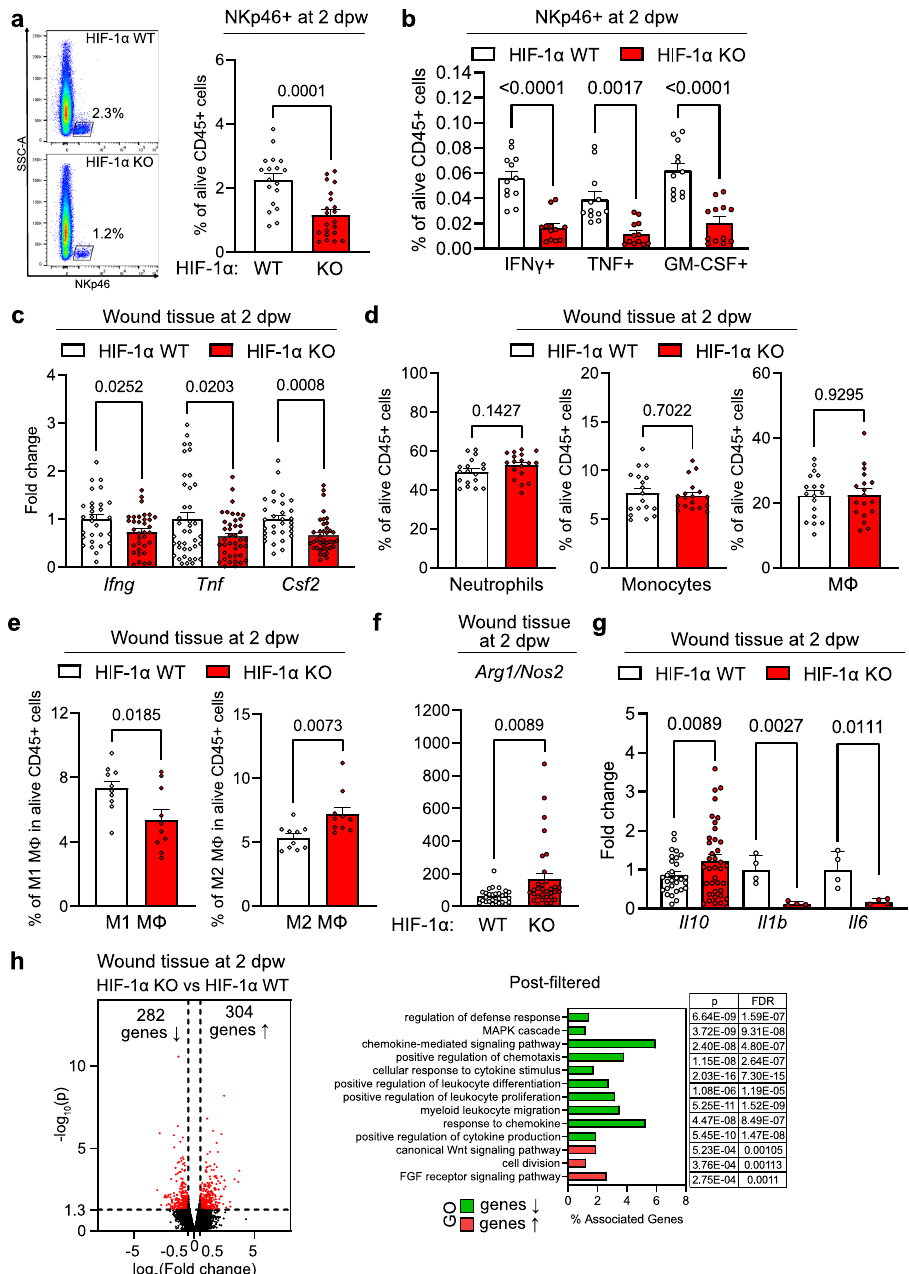
Fig. 2 HIF-1 α in NK cells controls the early cytokine response and skin regeneration. Analysis of skin wounds from WT and HIF-1 α KO animals at 2 days post wounding (dpw). a Left, FACS plots showing the percentage of NKp46 + cells within CD45 + cells. Right, quanti fi cation of NKp46 + cells, pooled data of 4 experiments, ( n = 18 mice for WT and n = 21 for HIF-1 α KO), two-tailed Student ’ s t test. b FACS analysis of IFN γ -, TNF- and GM-CSF-expressing NKp46 + NK1.1 + cells, pooled data of 3 experiments, ( n = 12 mice), two-tailed Student ’ s t test. c Gene expression of Ifng, Tnf and Csf2 , pooled data of 4 experiments, ( Ifng , n = 30 wounds for WT and n = 32 for HIF-1 α KO; Tnf n = 40 for WT and n = 40 for HIF-1 α KO; Csf2 , n = 30 for WT and n = 40 for HIF- 1 α KO), two-tailed Student ’ s t test. d FACS analysis for neutrophils (CD11b + , Ly6G + ), monocytes (CD11b + , Ly6C + ) and macrophages (CD11b + , Ly6C + , F4/80 + ), pooled data of 4 experiments, (n = 18 mice), two-tailed Student ’ s t test. e FACS analysis for M1 (CD80 + , MHCII + ) and M2 macrophages (CD206 + ), pooled data of 3 experiments, ( n = 10 mice), two-tailed Student ’ s t test. f Ratio of Arg1 and Nos2 expression, pooled data of 4 experiments, ( n = 28 wounds for WT and n = 32 for HIF-1 α KO), two-tailed Student ’ s t test. g Gene expression for Il10, Il1b and Il6 , pooled data of 4 experiments for Il10 and 2 experiments for Il1b and Il6 , ( Il10 , n = 30 wounds for WT and n = 38 for HIF-1 α KO; n = 4 for Il1b and Il6 ), two-tailed Student ’ s t test. h Left, volcano plot for RNA sequencing analysis. Red data points meet the thresholds of log 2 (FC) above 0.5 and under − 0.5, P < 0.05. Left, gene ontology (GO) prediction of the post fi ltered genes for the cytokines, chemokines and growth factors and corresponding receptors from the total pool of the signi fi cantly downregulated (282 genes) and upregulated genes (304 genes) with statistical readout ( p value and FDR). Differential expression analysis was performed using the DESeq2 R package along with Wald test. Data are mean values ±